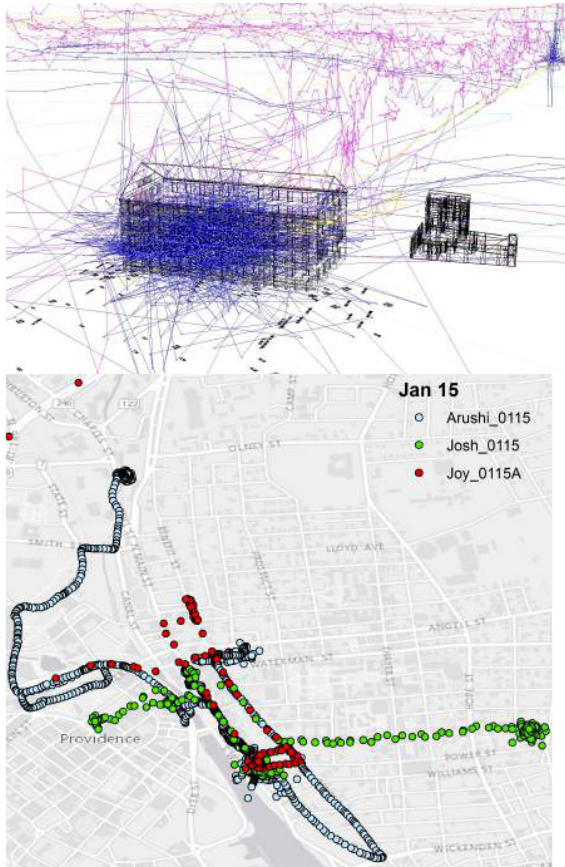
Figure 7: Overlay of local movement by all four subjects around the BEB Architecture building. Top rendering in a 3-d Rhino environment; Bottom rendering, Open Street Maps, in which each point represents the 15 second interval data logged .